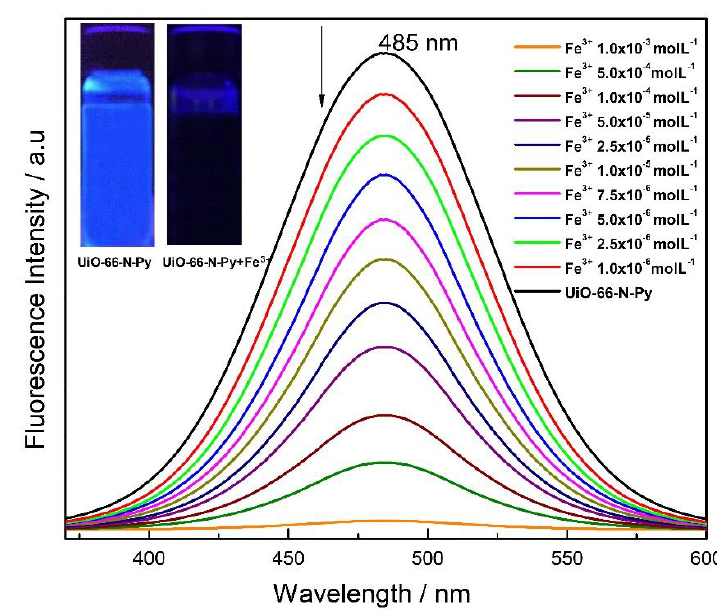
Figure 5. Changes in fluorescence emission spectra of UiO-66-N-Py with the incremental addition of FeCl 3 (10 −2 M) in water (λ exe = 341 nm). Inset: Fluorogenic changes in UiO-66-N-Py upon addition of Fe 3+ in water upon illumination at 365 nm.